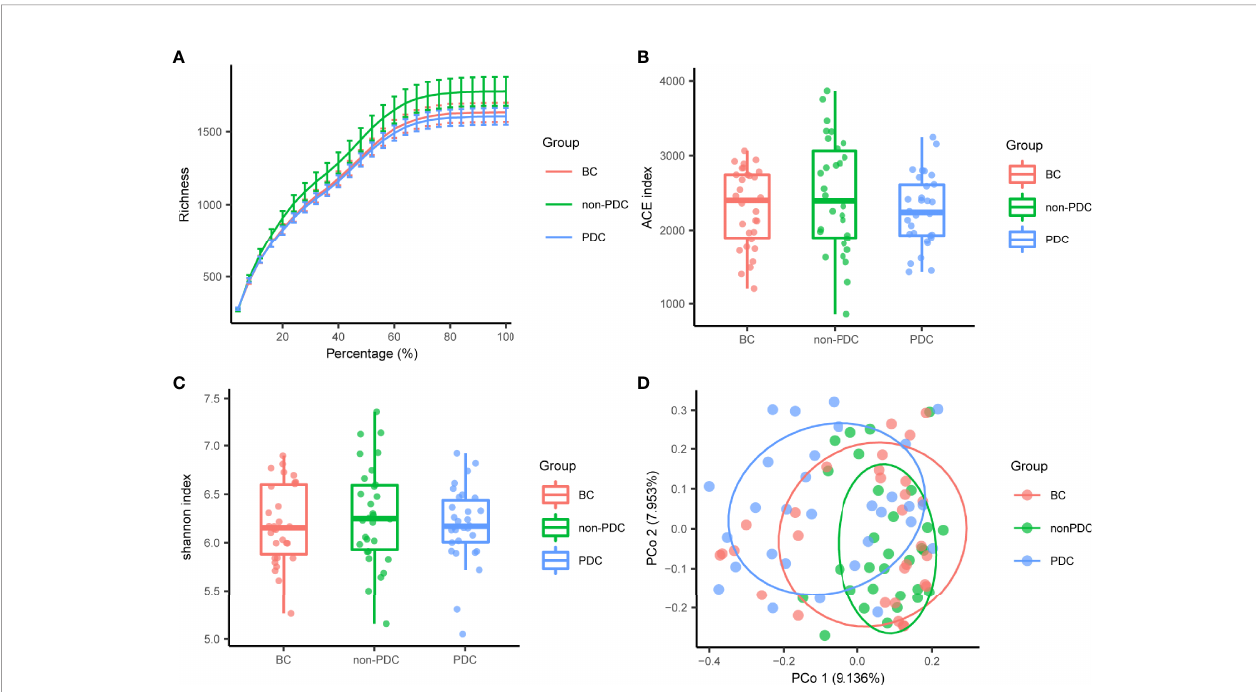
FIGURE 1 | Gut microbiome diversity and structure analysis. (A) Rarefaction curve evaluating the relative bacterial richness to determine whether further sequencing would identify additional ASVs. BC, Balanced Constitution group; PDC, Obesity with phlegm-dampness constitution group; non-PDC: obesity without phlegm- dampness constitution group. (B , C) Species diversity differences among the PDC, non- PDC and BC groups were estimated by ACE index and Shannon index. (D) PCoA with Bray – Curtis distance showing that the overall microbial composition of three groups. BC (red dots); non-PDC group (green dots); PDC group (blue dots), where dots represent individual samples.